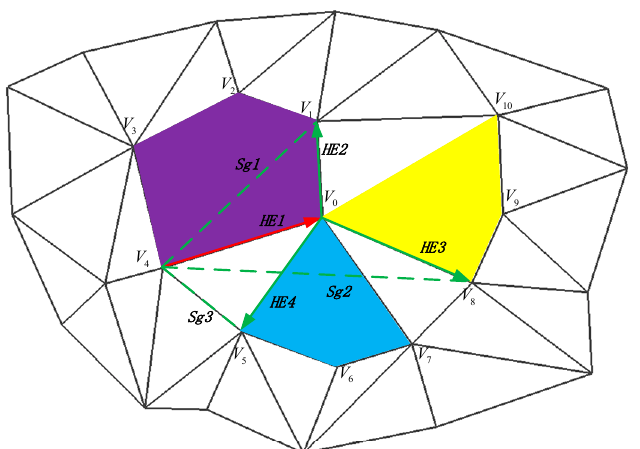
V . The half-edges are